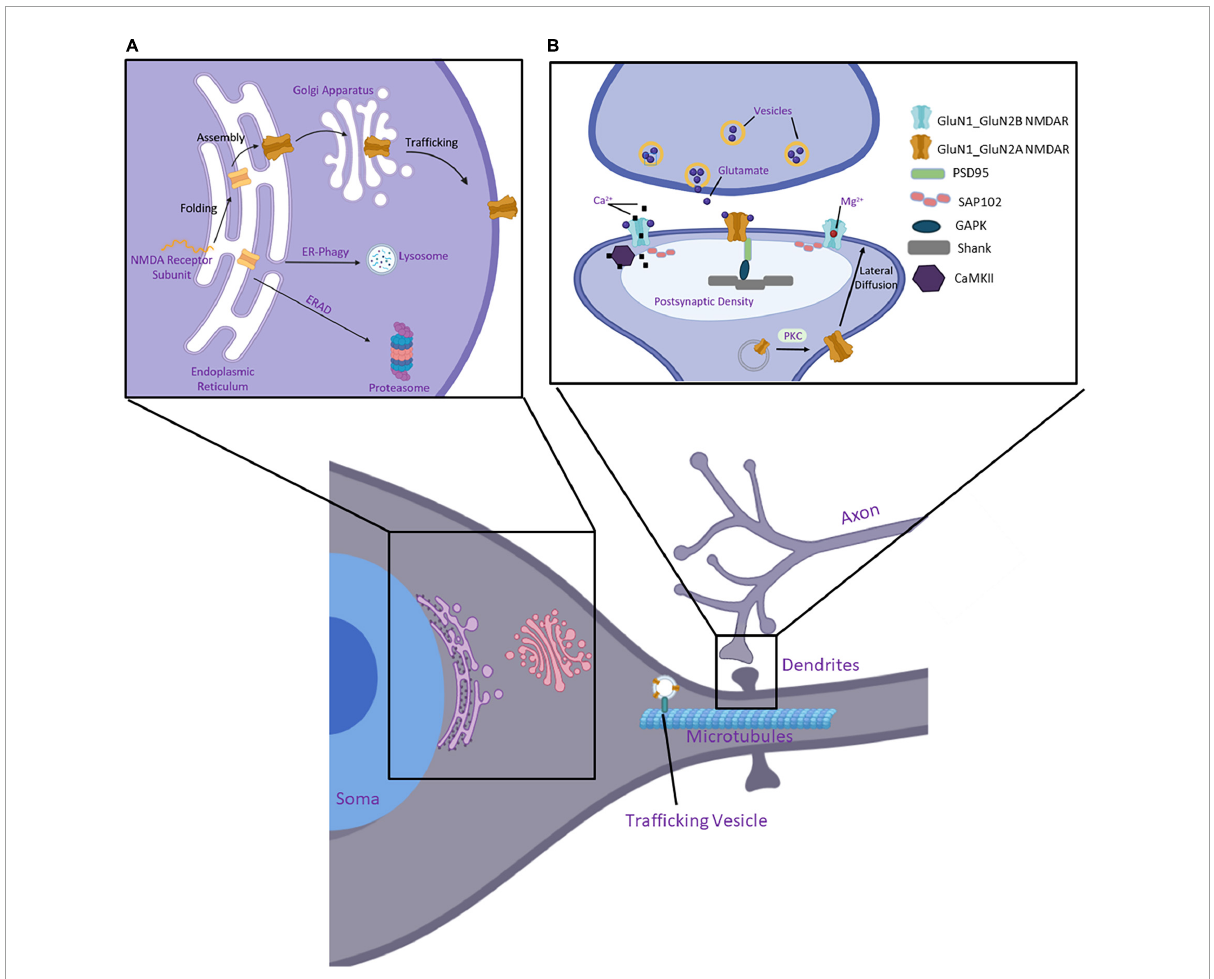
FIGURE3 Essential components of the protein quality control pathway of NMDARs. (A) Nascent polypeptide chains of a GluN subunit enter the ER where chaperone proteins and folding enzymes assist its folding and assembly. Furthermore, it is trafficked to the Golgi apparatus, where it undergoes post-translational modifications, and eventually inserts into the plasma membrane to perform its function. If incorrectly folded within the ER, the protein is targeted to a degradation pathway, either through ER-phagy or ER-associated degradation (ERAD). (B) NMDARs are organized at synapses within the postsynaptic density (PSD). Protein kinase C (PKC) facilitates vesicle fusion with the membrane and the receptors laterally diffuse to the synaptic space. NMDARs are tethered to the PSD through interactions of their CTD with SAP102 and PSD95. These are further linked to Shank and Homer within the PSD. CaMKII binds and modulates NMDARs activity and calcium signaling at the synapse. Created with